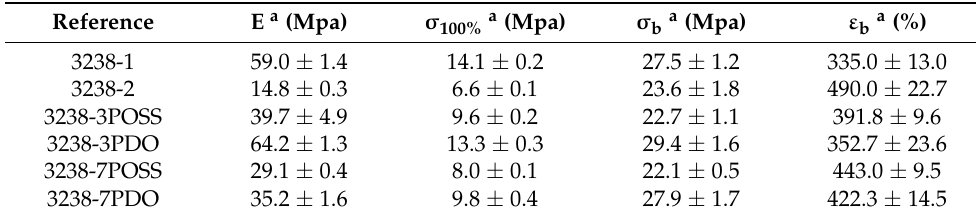
Table 5. Mechanical characterization of WPUD films.